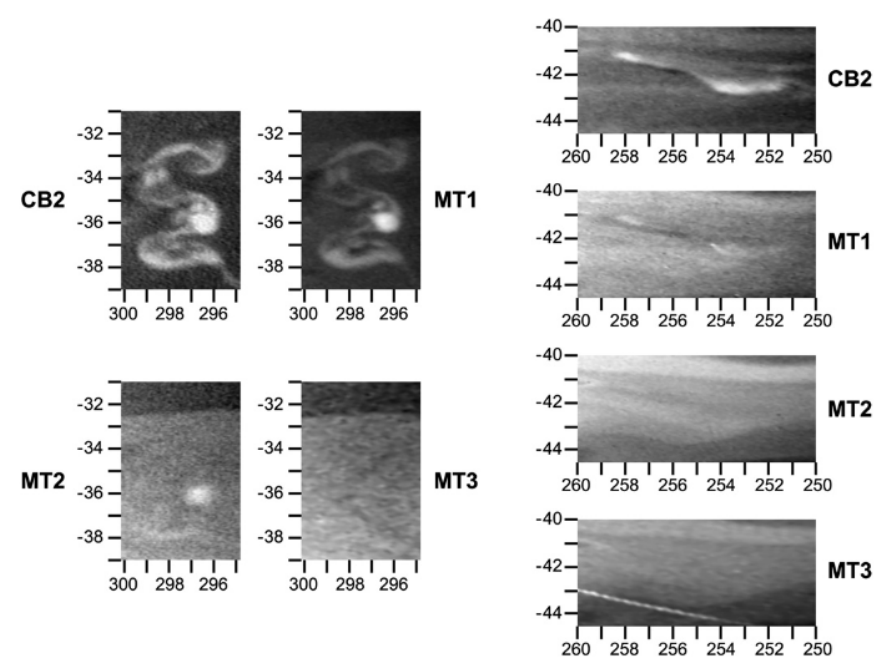
Figure 6. Local convective storms observed by Cassini . These storms are bright in the continuum band (visible wavelengths), but do not share this contrast in the infrared. Adapted from